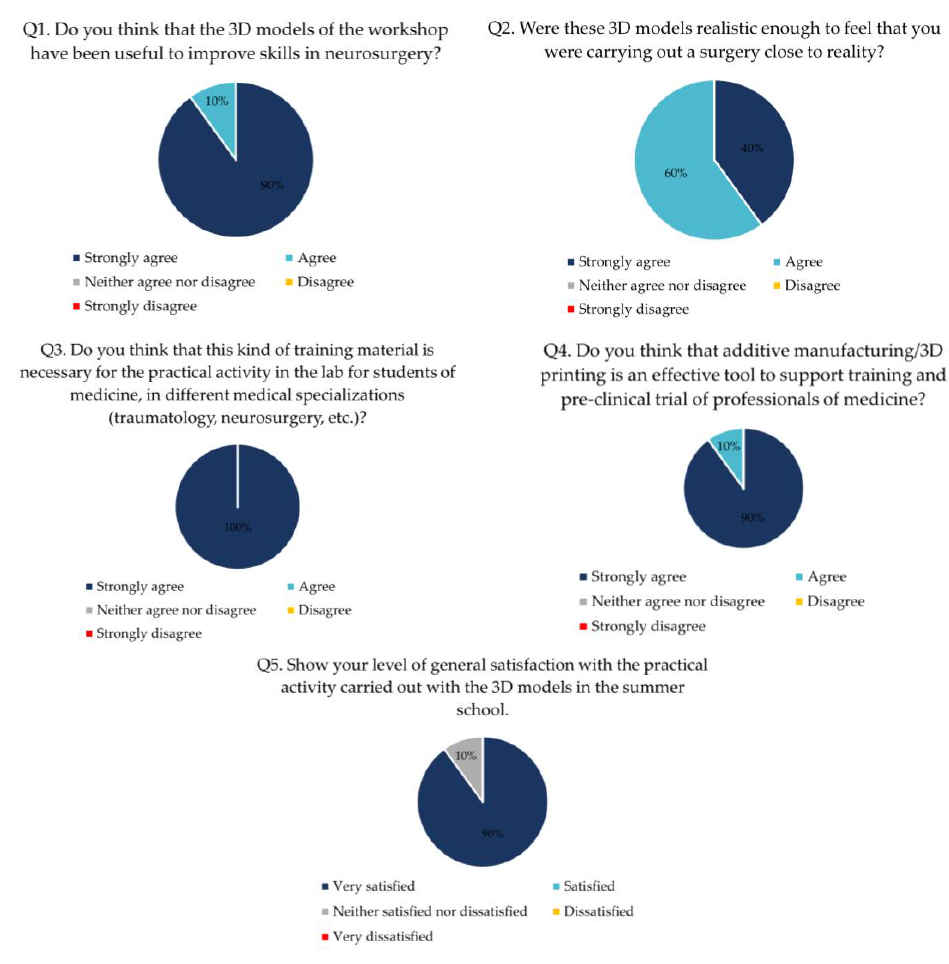
Figure 12. Survey on 3D